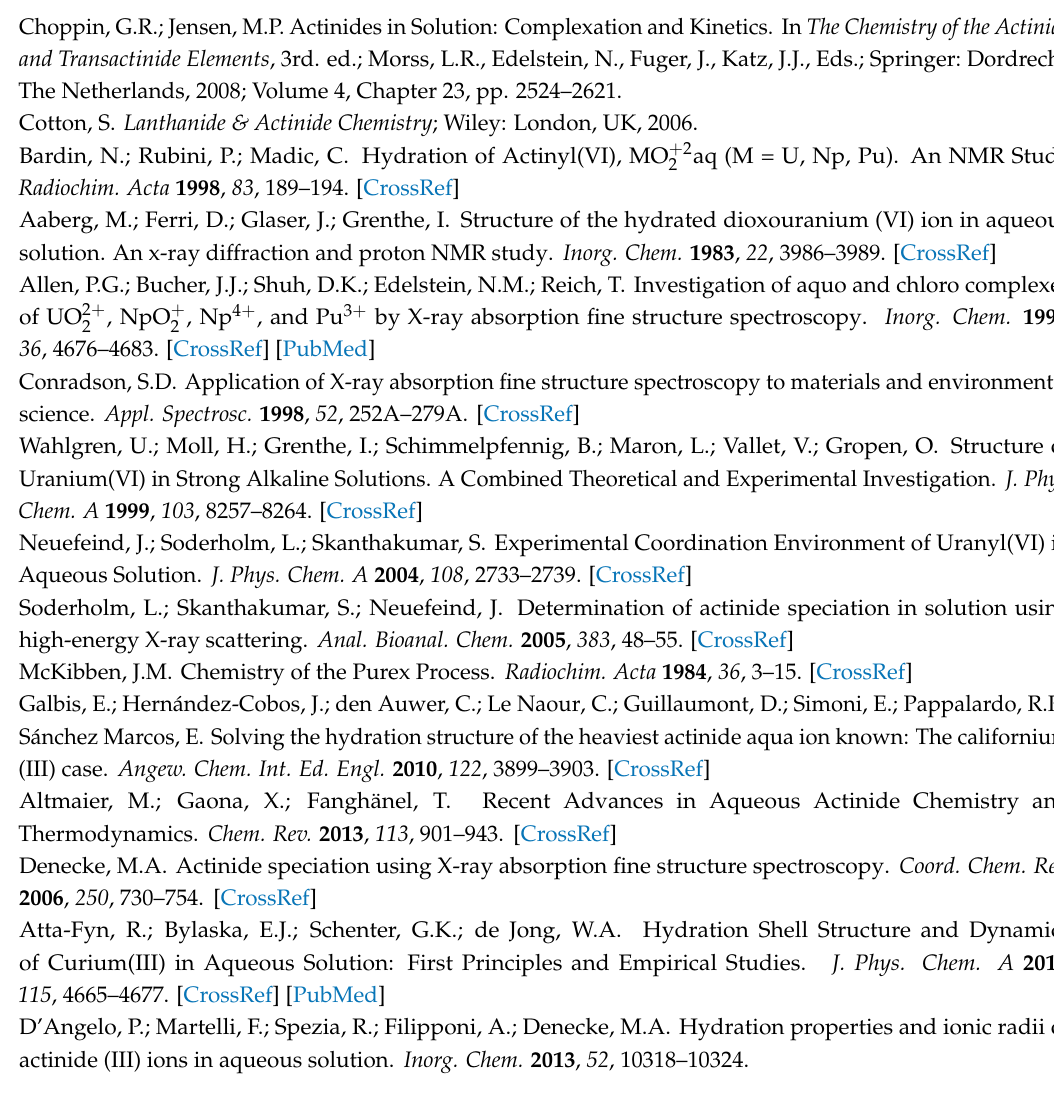
Supplementary Materials: The following are available online: Table S1: First-shell water geometry, Tables S2–S5: Potential parameters. Figures S1 and S2: FEFF input files, Figure S3: Plutonyl EXAFS spectrum form B3LYP simulation obtained by averaging 200 or 500 snapshots, Figure S4: Uranyl EXAFS spectrum from the MP2 optimized geometry vs. experimental